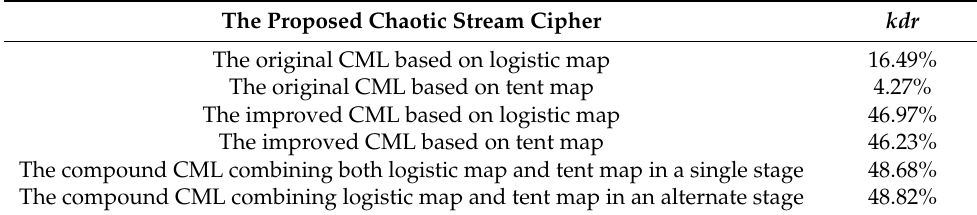
Table 2. The keystream difference rate ( kdr ) of the proposed chaotic stream